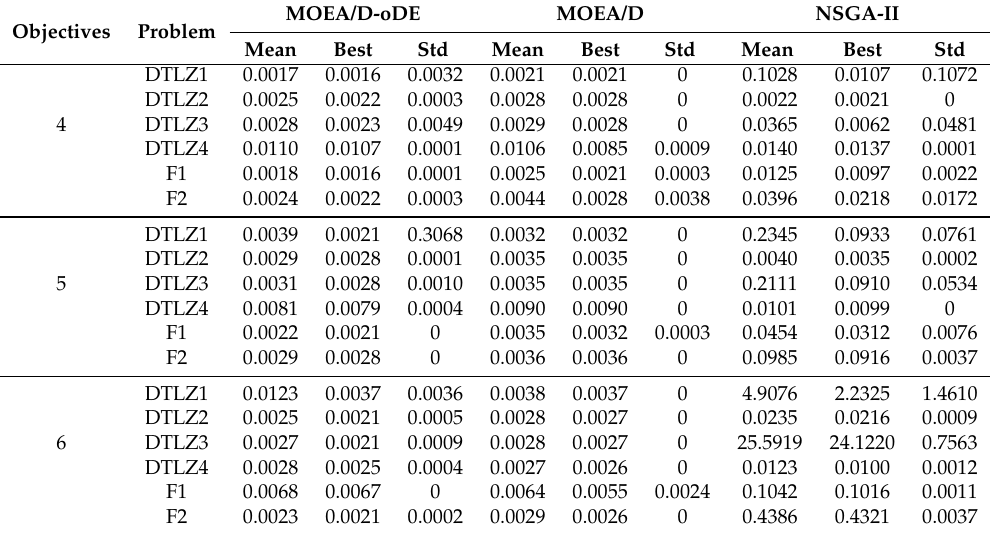
Table 5. Statistics of the GD metric obtained by MOEA/D-oDE, MOEA/D and NSGA-II on the test